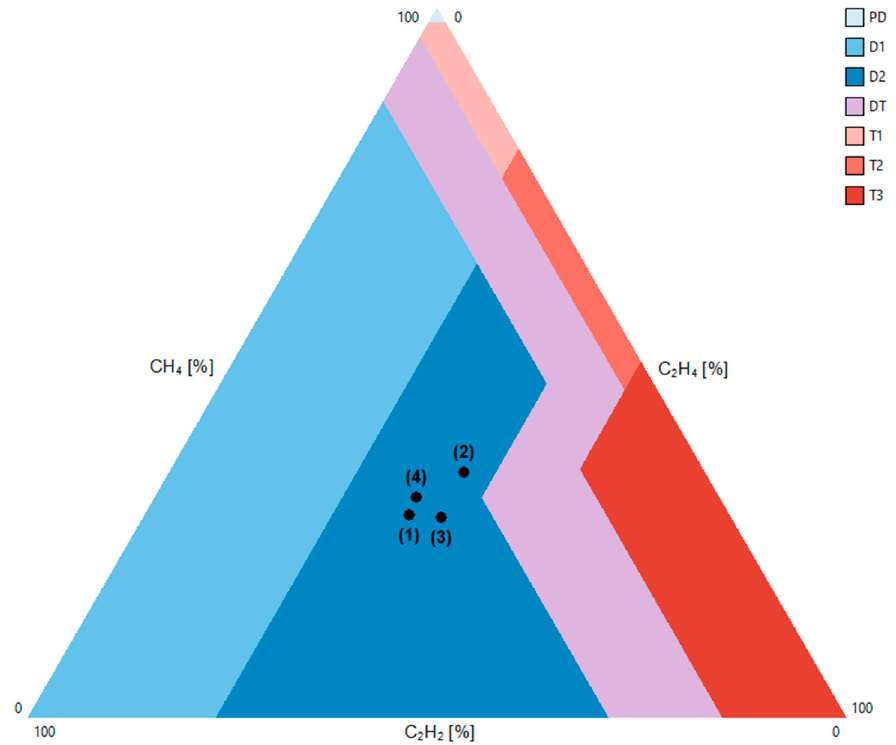
Figure 7. Faults detected in the bushing using Duval’s triangle (the numbers in the brackets correspond to the numbers of cases in Table 10).